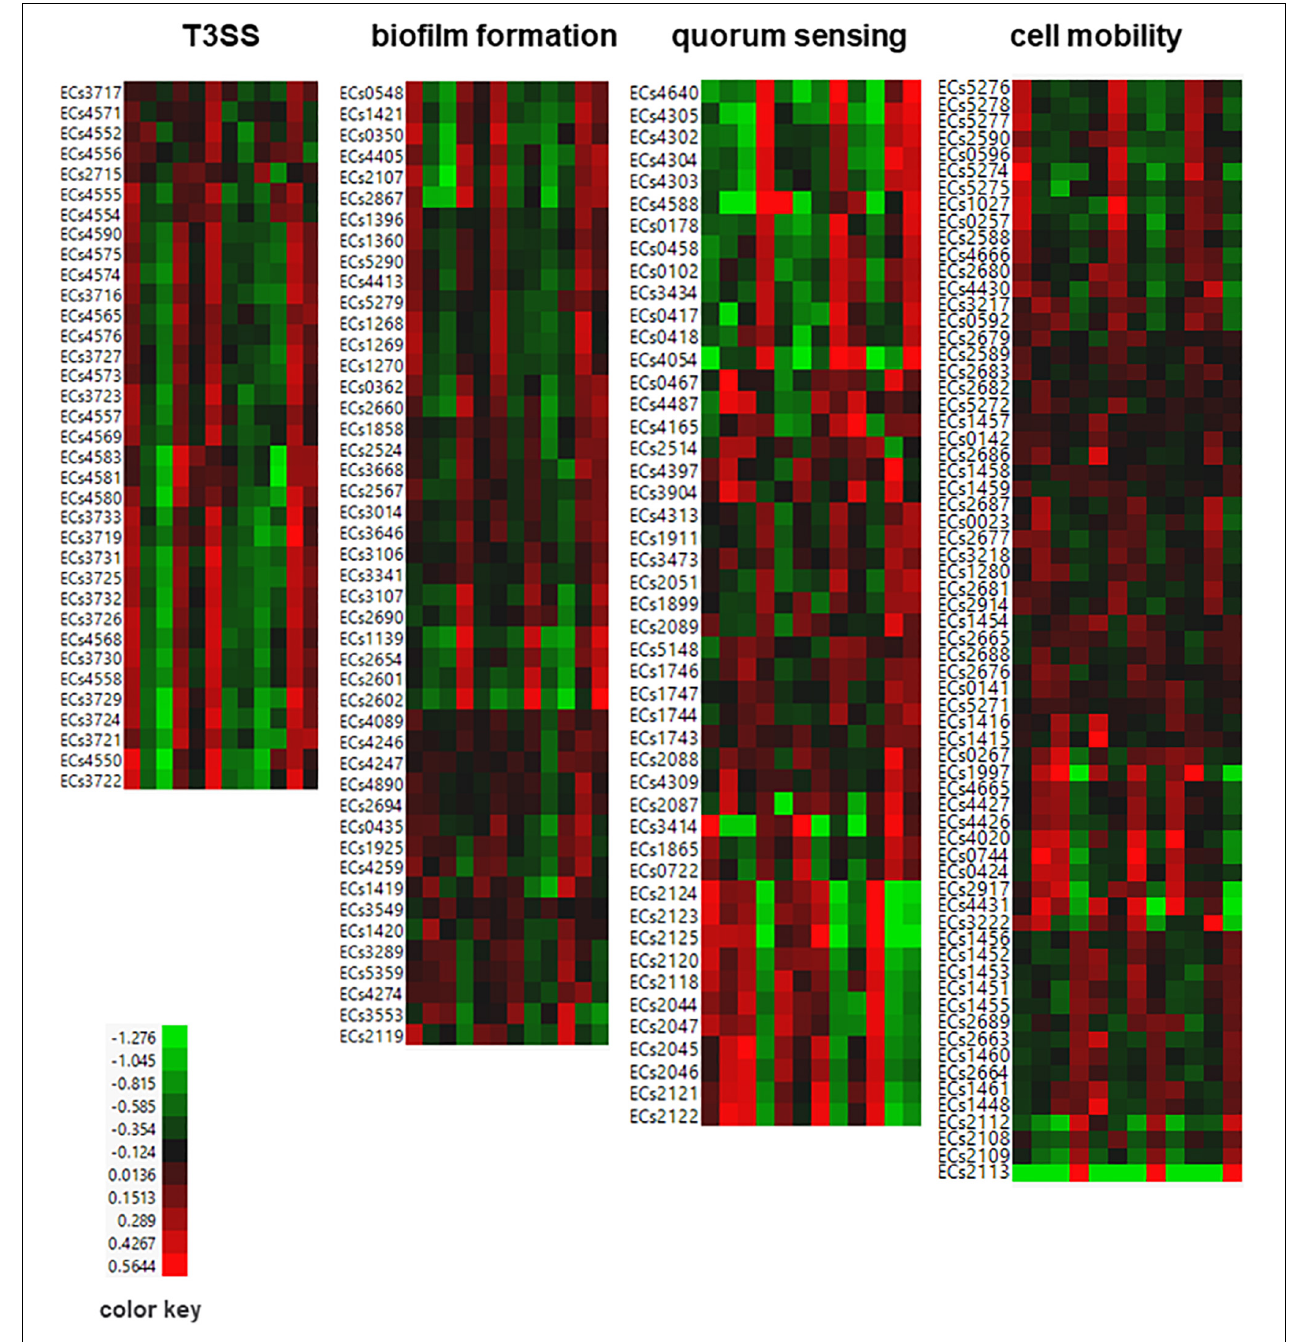
FIGURE 5 | Heat map of differentially expressed E. coli genes associated with T3SS, biofilm formation, quorum sensing, and cell mobility. Propensity values of E. coli genes in response to 1 µ g, 5 µ g, and 10 µ g of ClO 2 after 1 h, 2 h, and 3 h were plotted. Red indicates high expression and green indicates low expression.